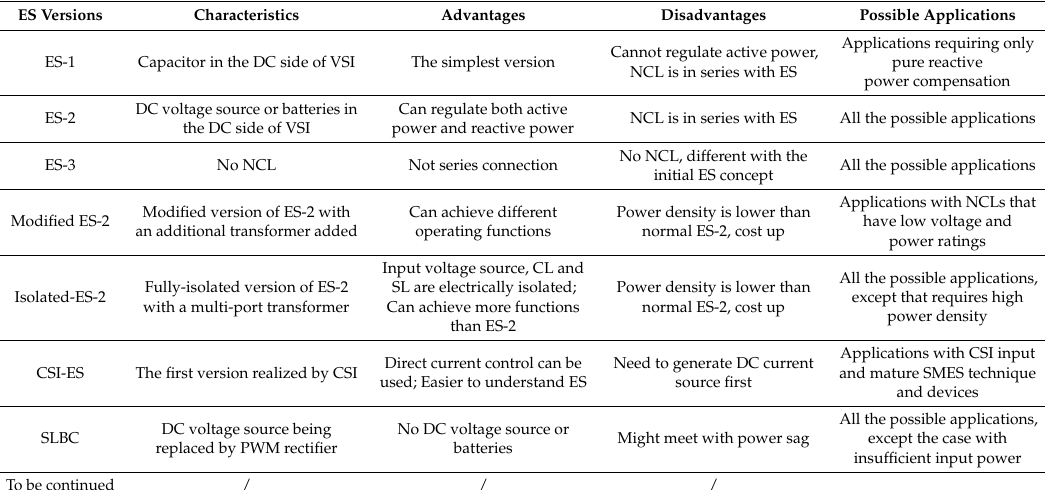
Table 1. Relationships and Comparisons between Different Single-Phase